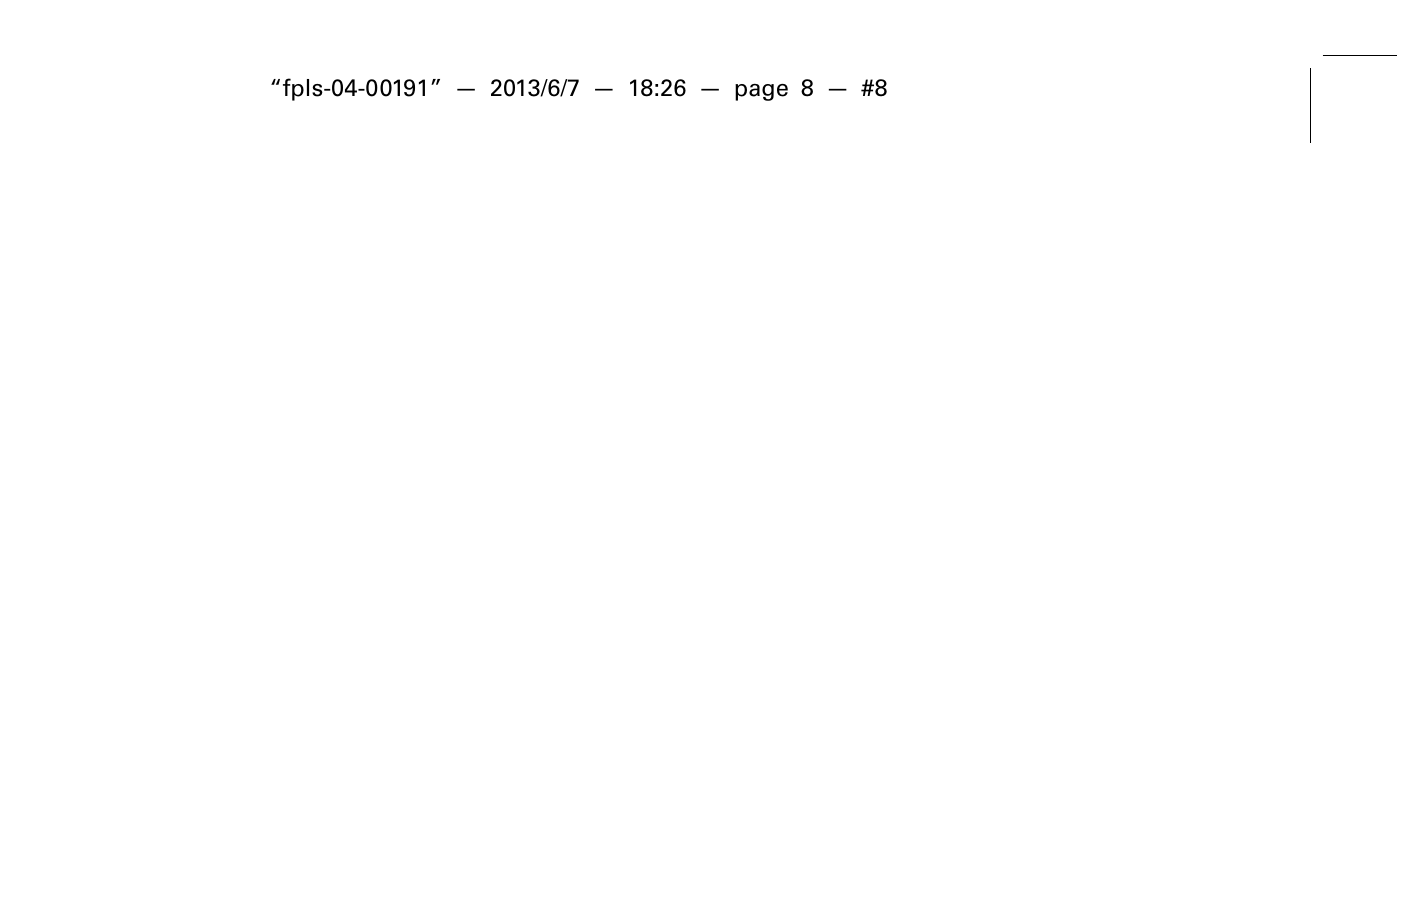
FIGURE 1 | Schematic diagram of the interactions between the bacterial necrotroph Pectobacterium and its host plants. Pectobacterium virulence relies on macerating plant tissue through the action of PCWDEs secreted by the type I (T1) and type II (T2) secretion systems. Plant cell death is promoted by the action of toxins such as Nip and the effector DspE, which is secreted though the type III (T3) secretion system.Type IV (T4) secretion system and typeVI (T6) secretion system may contribute to virulence. Plant immune responses are triggered by recognition of conserved pathogen-associated molecular patterns (PAMPs) such as flagella or damage-associated molecular